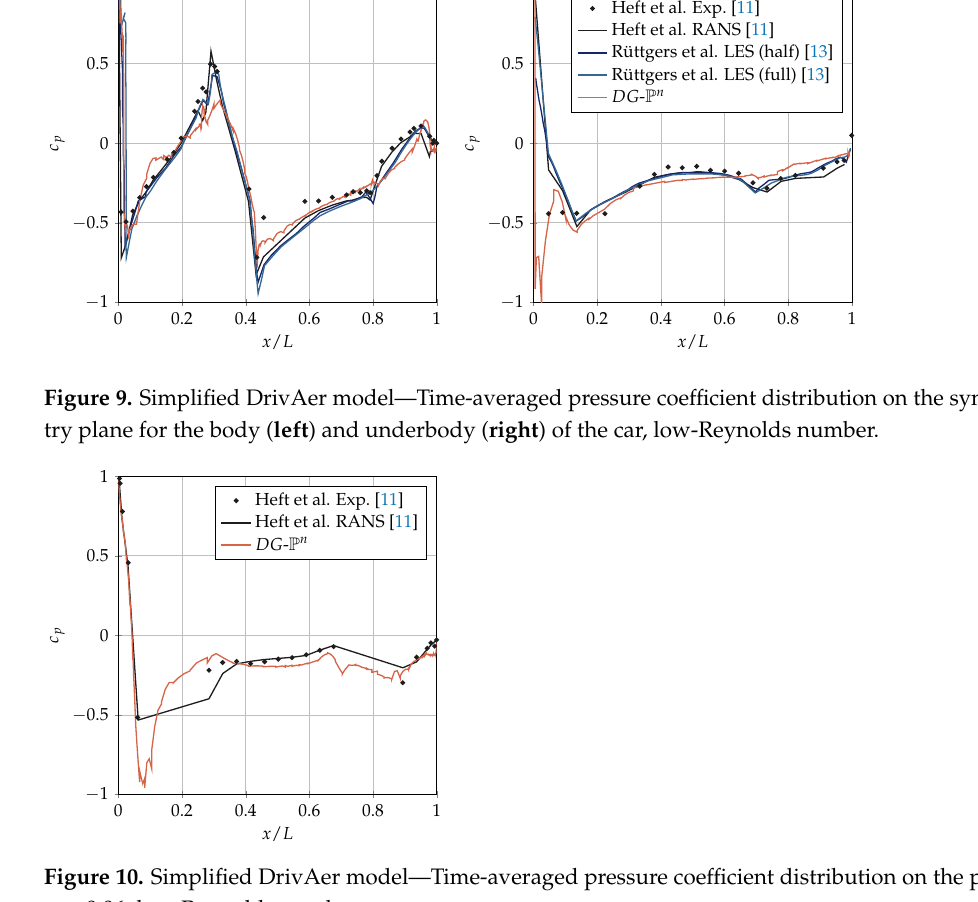
Figure 10. Simplified DrivAer model—Time-averaged pressure coefficient distribution on the plane z = 0.06, low-Reynolds